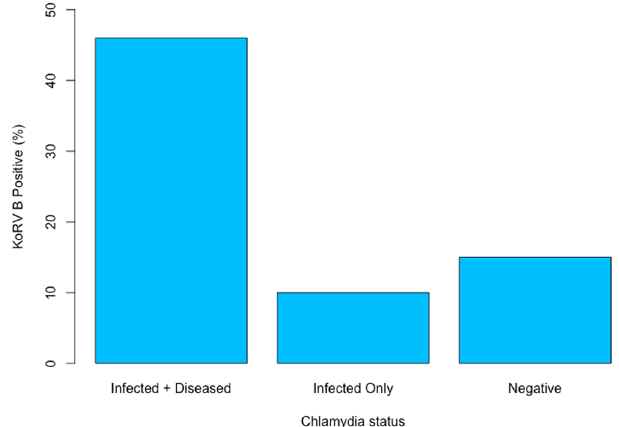
Figure 4. Percentage of koalas ( Phascolarctos cinereus ) infected with koala retrovirus sub type B (KoRV B) versus Chlamydia pecorum status. Infected + diseased = animals positive for chlamydial disease (n = 6/13). Infected Only = animals with long term chlamydial infection (as measured by PCR) but that remained asymptomatic/no clinical disease over the one year of the study (n = 1/10). Negative = animals that remained chlamydial negative for longer than 12 months (n = 2/13).